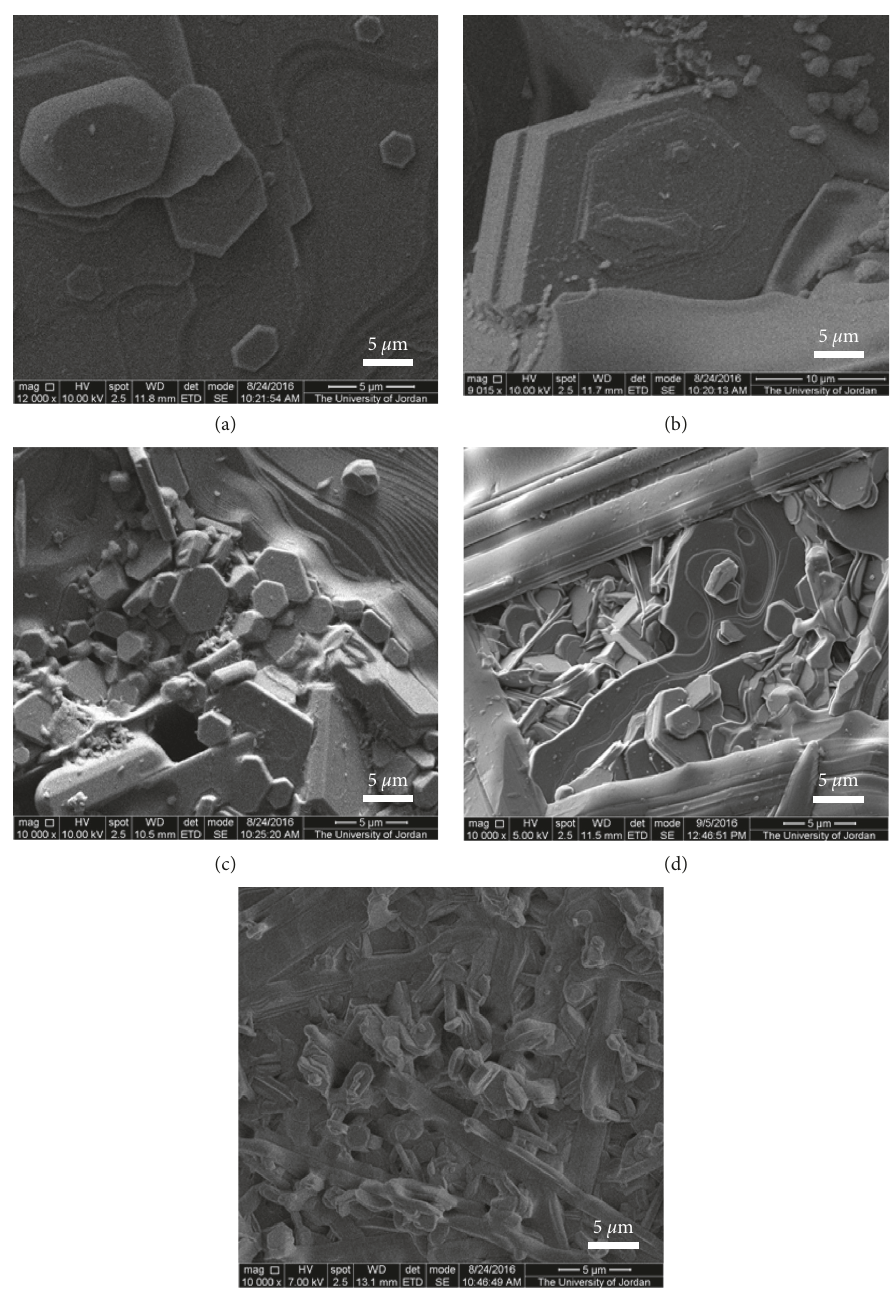
Figure 3: SEM images for the Ba